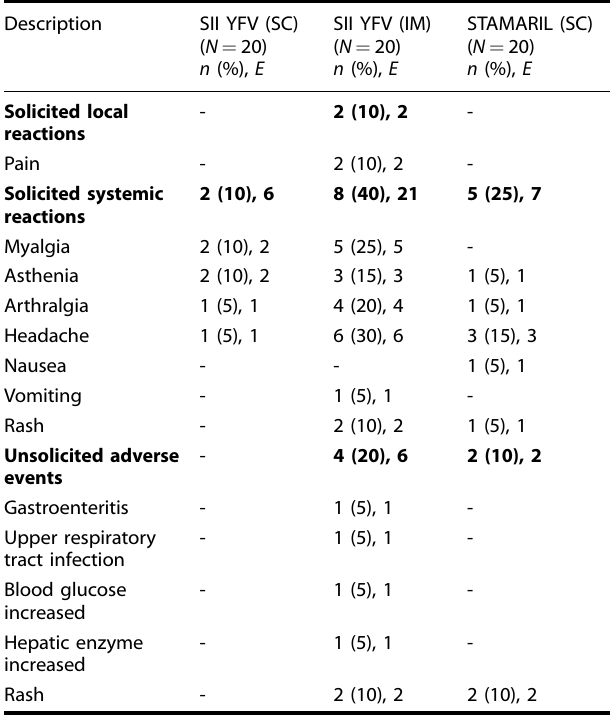
Table 2. Solicited reactions and unsolicited adverse events reported by